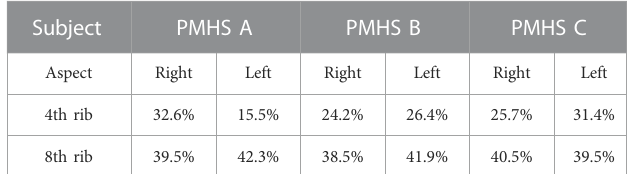
TABLE 4 Relative position of the nodes used for chest de fl ection measurement from the sternum along each rib for the three